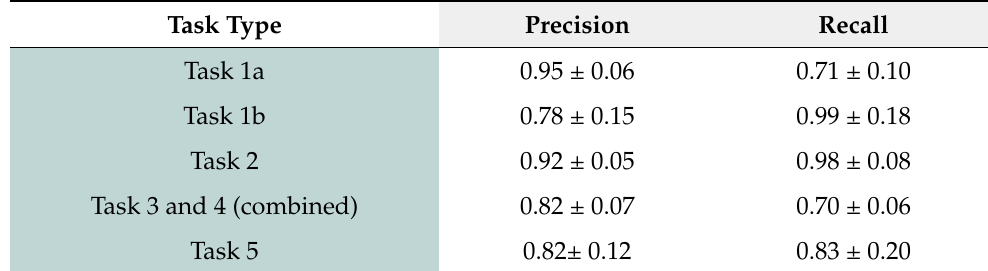
Table 5. Average precision and recall of all participants, based on the 5 label